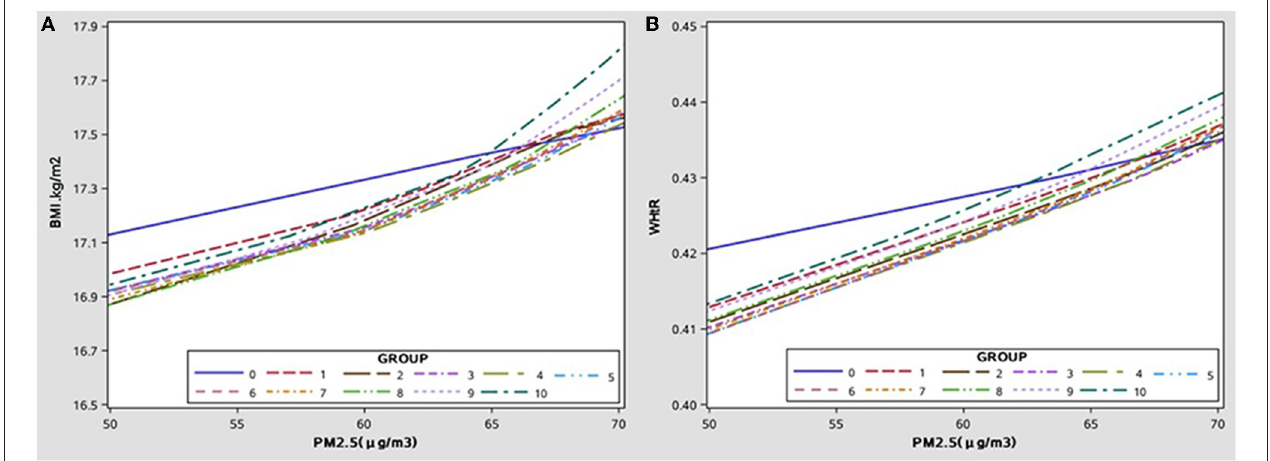
FIGURE 2 | The cumulative effect of PM2.5 exposure levels to different ages on BMI/WHtR, after adjusting covariate. (A) The cumulative effect of PM2.5 on BMI with age. (B) The cumulative effect of PM2.5 on WHtR with age.